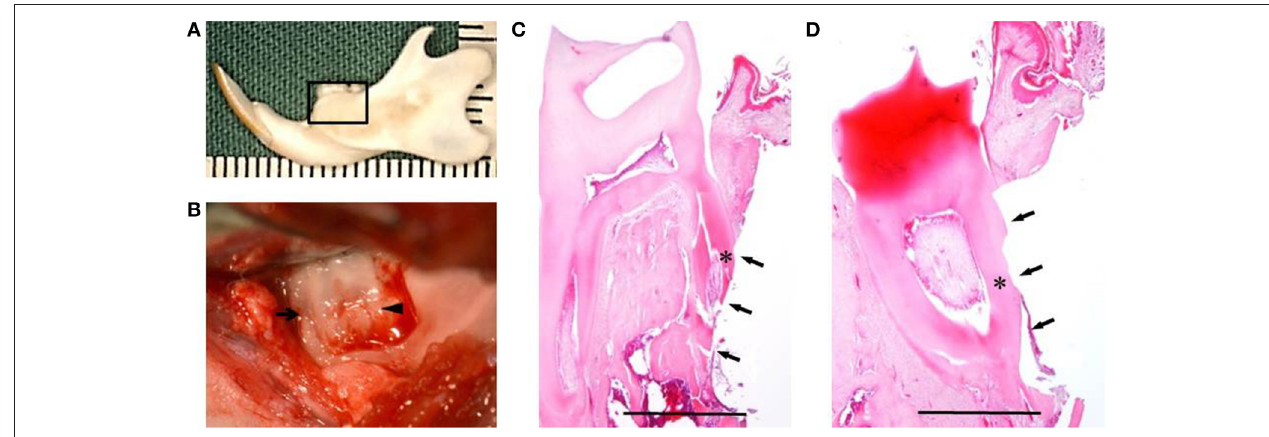
FIGURE 2 | Creation of the periodontal fenestration defect. (A) Rat mandibular frame specimen. The black flame indicates the site of the surgically created periodontal fenestration defect site. (B) Macroscopic view of a surgically created periodontal defect on the buccal surface of the mandibular first molar. The arrow indicates the first molar mesial root and the arrowhead indicates the first molar distal root. (C) H&E staining showing the surgically exposed central root of the first mandibular molar. The defect includes alveolar bone, periodontal ligament, and cementum. The arrows indicate the defect site and the asterisk indicates the central root of the first molar on the buccal side. Scale bar = 1000 µ m. (D) H&E staining showing surgically exposed distal root of the first mandibular molar. The arrows indicate the defect site and the asterisk indicates the distal root of the first molar on the buccal side. Scale bar = 1000 µ m.